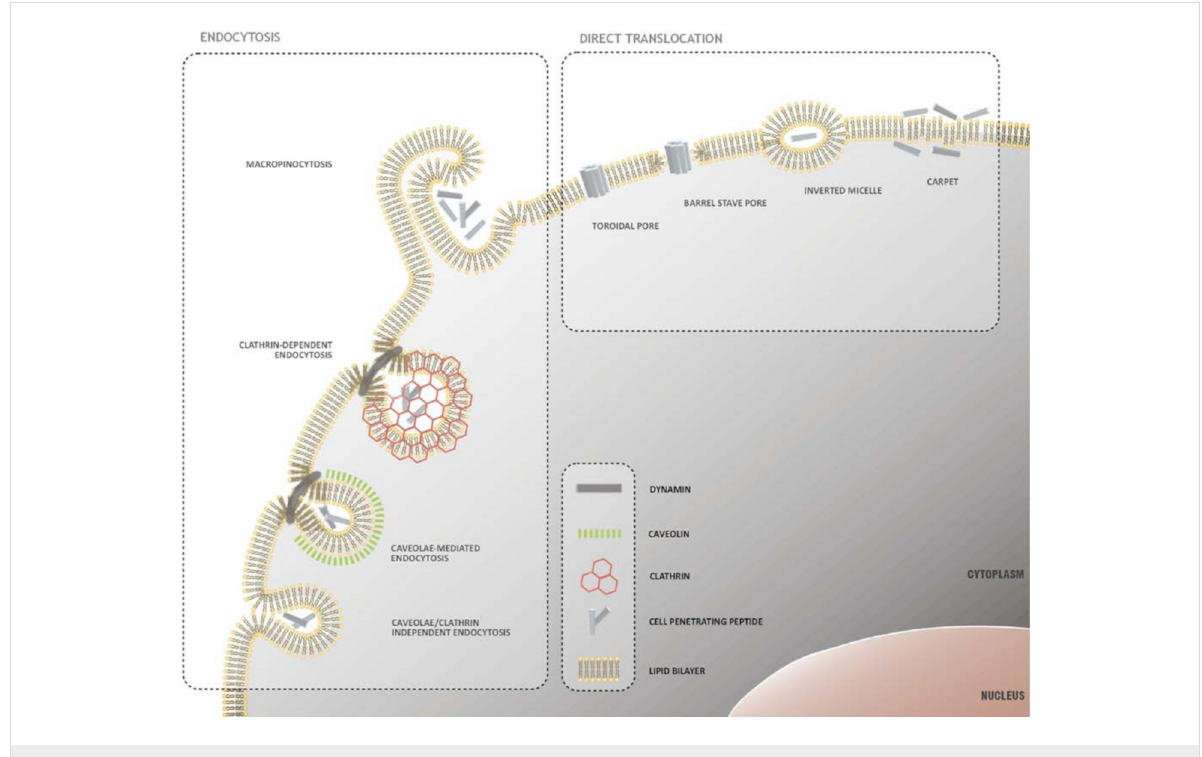
Figure 1: Mechanisms of CPP uptake. Two main mechanisms have been proposed: direct translocation through the cellular membrane, which requires no energy, and endocytosis, an energy-dependent process. Reprinted from [23], copyright Trabulo et al., 2010. CC-BY 3.0